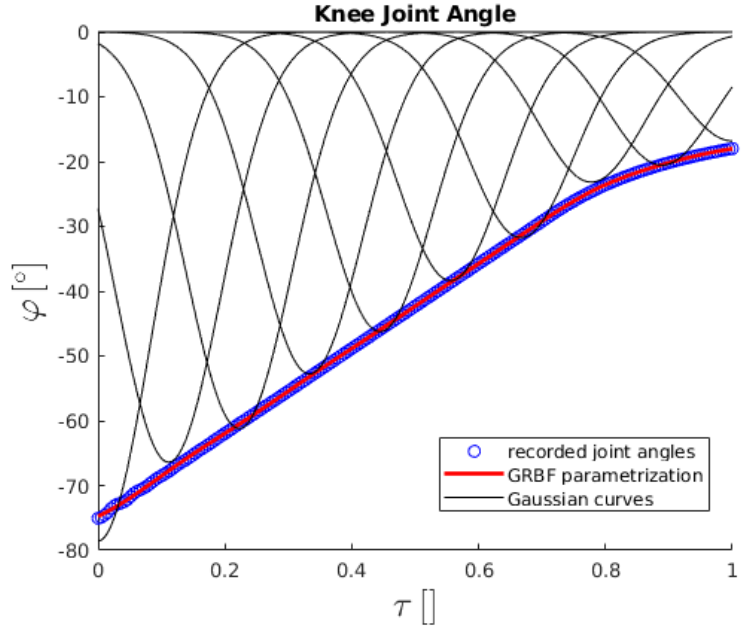
Figure 7. The knee joint angle of the humanoid robot during the standing-up motion as a function of phase τ . The blue empty circles are the recorded knee joint angles, the black curves are the Gaussian functions, and the red curve is the GRBF parametrization from Equation (12) of the knee joint angle, composed from the Gaussian curves from Equation